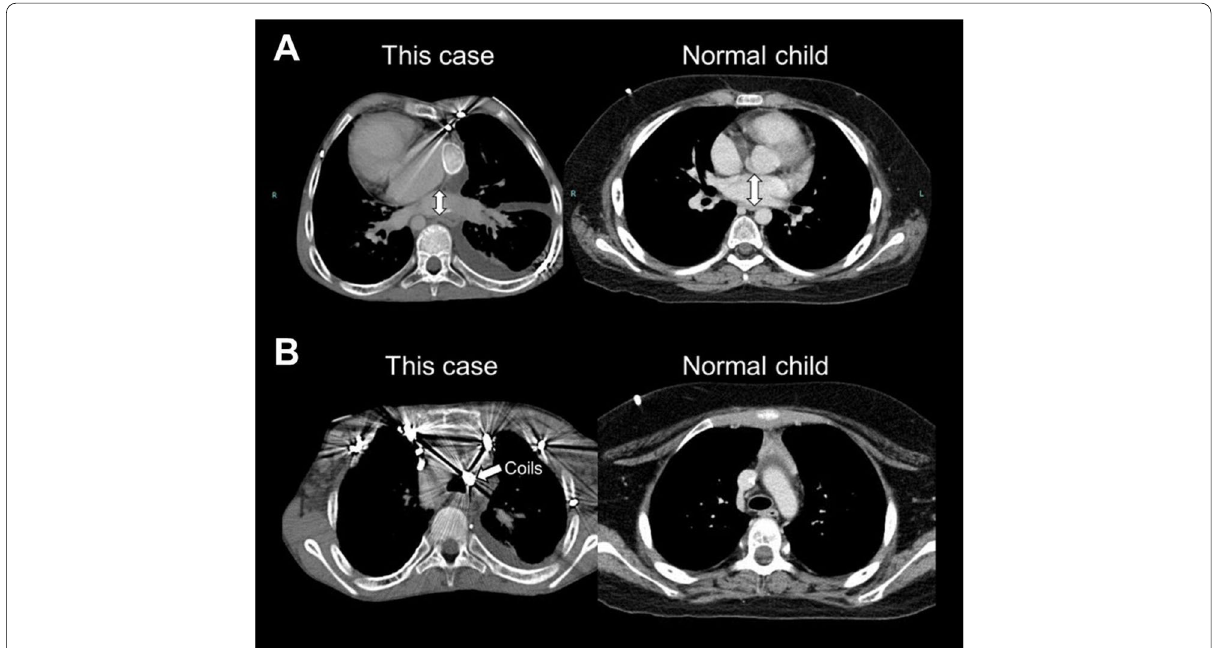
Fig. 4 Transverse CT image at the levels of the common pulmonary venous cavity ( A ) and tracheal bifurcation ( B ) in this patient (left) and in a normal child (right). Note the smaller anterior-posterior diameter of the common pulmonary venous cavity in this case (left) compared with that of the left atrium in a normal child (right) ( A ) and the coils for embolizing the major aortopulmonary collateral arteries in front of the tracheal bifurcation (left) ( B